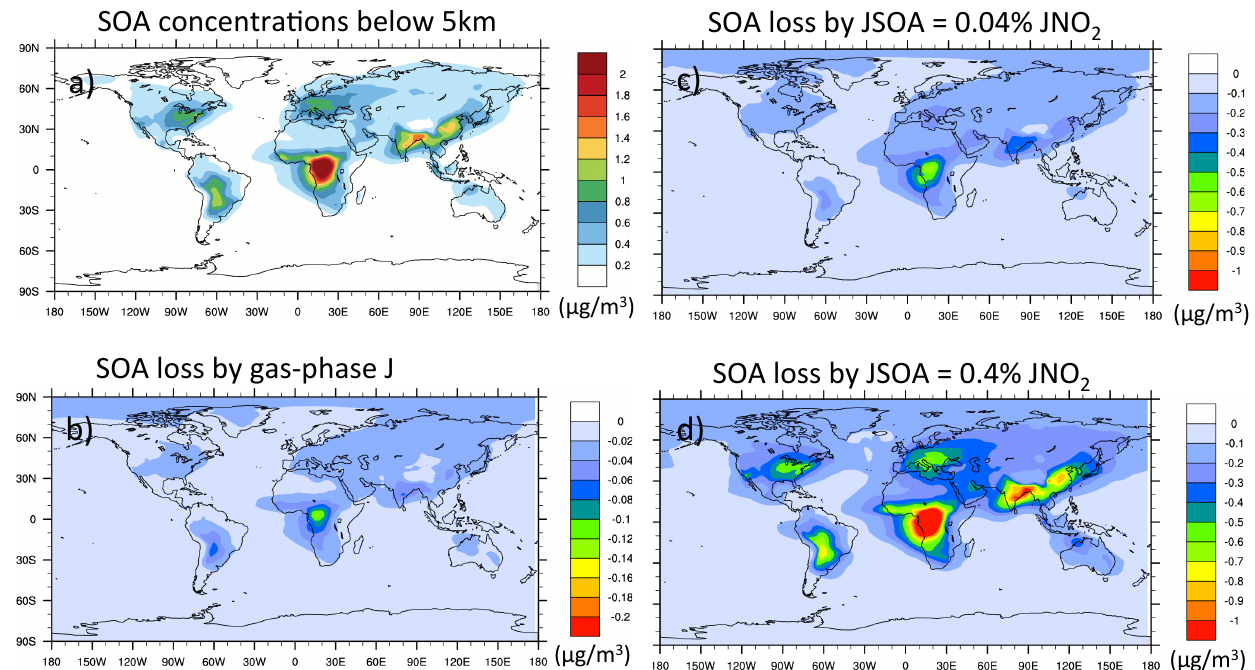
Figure 7. GEOS-Chem simulation for 2009 showing (a) the SOA concentrations within the lower troposphere (below 5km) and the absolute (µgm − 3 ) reductions in SOA concentrations due to gas-phase (b) and particle-phase (c, d) photolysis. Gas-phase photolysis is applied to semi-volatile organic compounds using the e -folding J lifetime of 20 days as estimated in Table 3. Two in-particle photolysis rates are considered, i.e., J SOA of 0.04% J NO (c) and J SOA of 0.4% J NO (d) 2 2